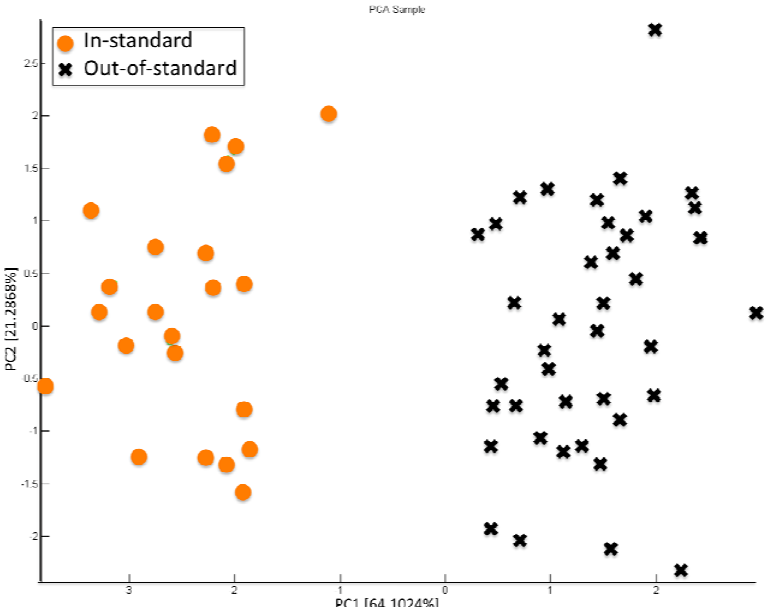
Figure 14. PCA score plot of data related to in standard (orange circles) and out-of-standard (black x) processed tomatoes. Reprinted from [47] with permission from AIP, copyright